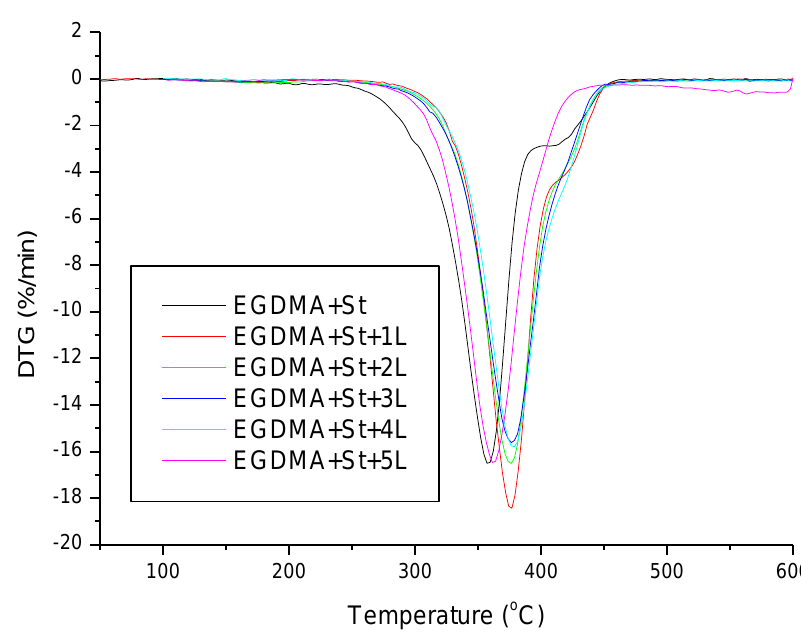
Figure 10. Derivative thermogravimetric curves of the obtained materials.